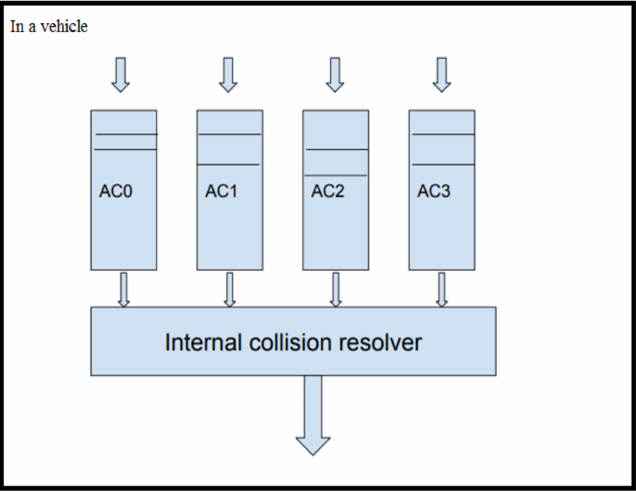
Figure 2. Working of IEEE